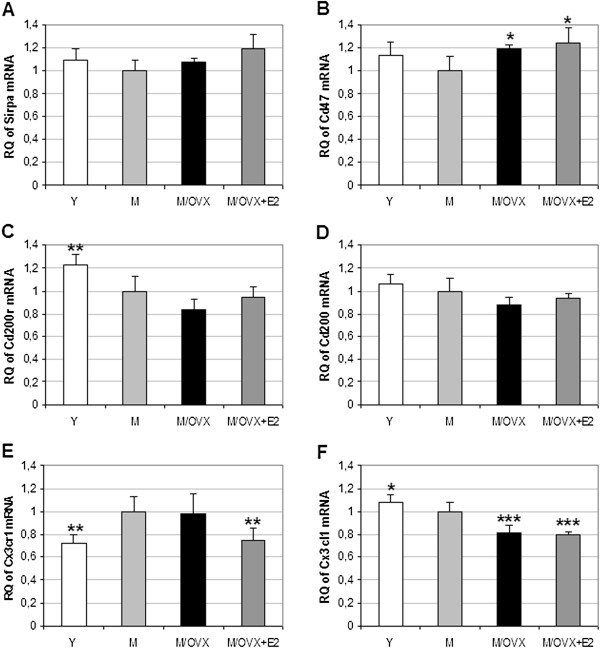
Age- and ovarian hormone-dependent regulation of genes encoding microglial receptors and their inhibitory neuronal ligands in the rat frontal cortex. TaqMan-based quantitative real-time PCR revealed no change in Sirpa (A), increase in the expression Cd47 (B), decrease in mRNA expression of Cd200r (C), Cd200 (D) and Cx3cl1 (F). Cx3cr1 (E) increased during aging. Error bars show SD of six independent measurements. Statistical significance of the alterations in different groups compared to middle-aged female rats (M) was determined by analysis of variance (ANOVA) with Newman-Keuls post hoc test, and considered at P <0.05. Asterisks indicate changes with statistical significance: *corresponds to 0.01<P < 0.05, ** to 0.001<P < 0.01 and *** to P < 0.001. Y, young rat; M/OVX, middle-aged OVX rat; M/OVX+E2, middle-aged ovariectomized (OVX) rat treated with 17β-estradiol (E2).